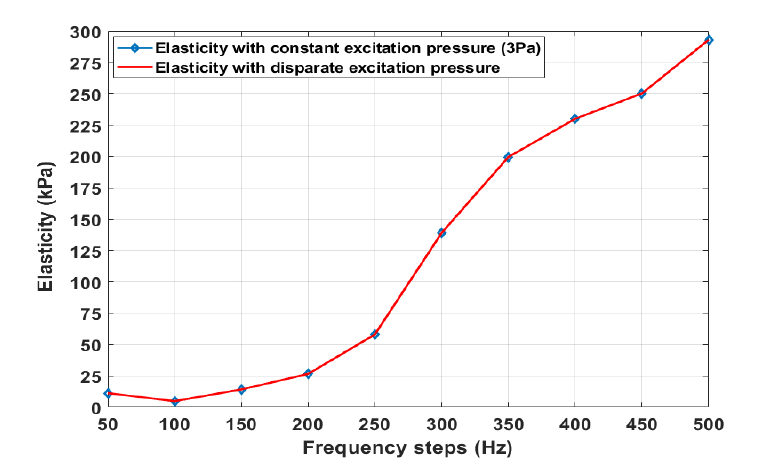
Figure 7. Calculated modulus of elasticity by the two pressure